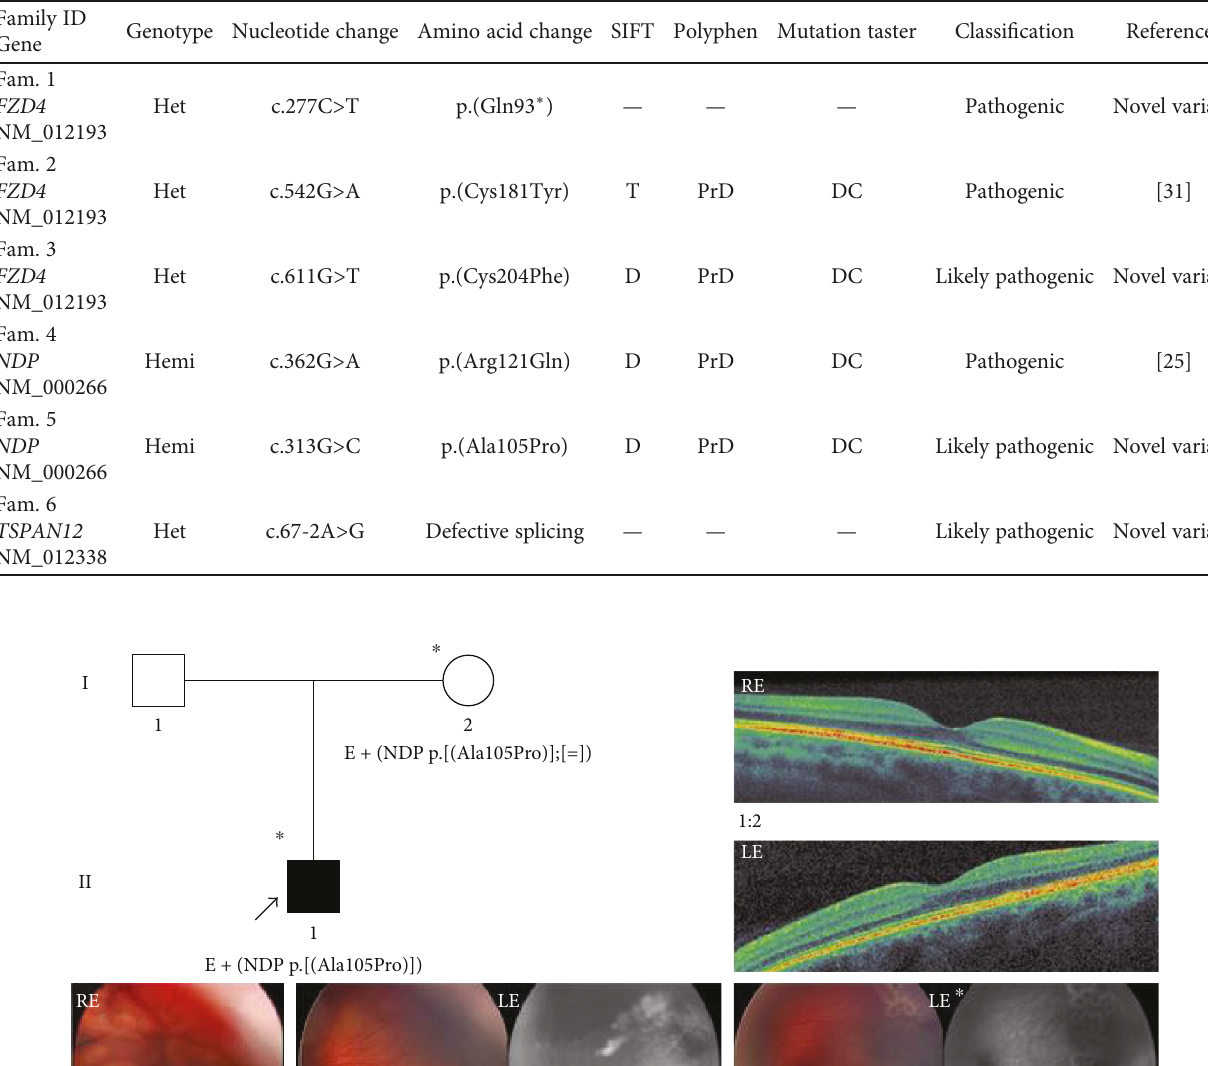
Table 1: Features of genetic variations found in FEVR families.